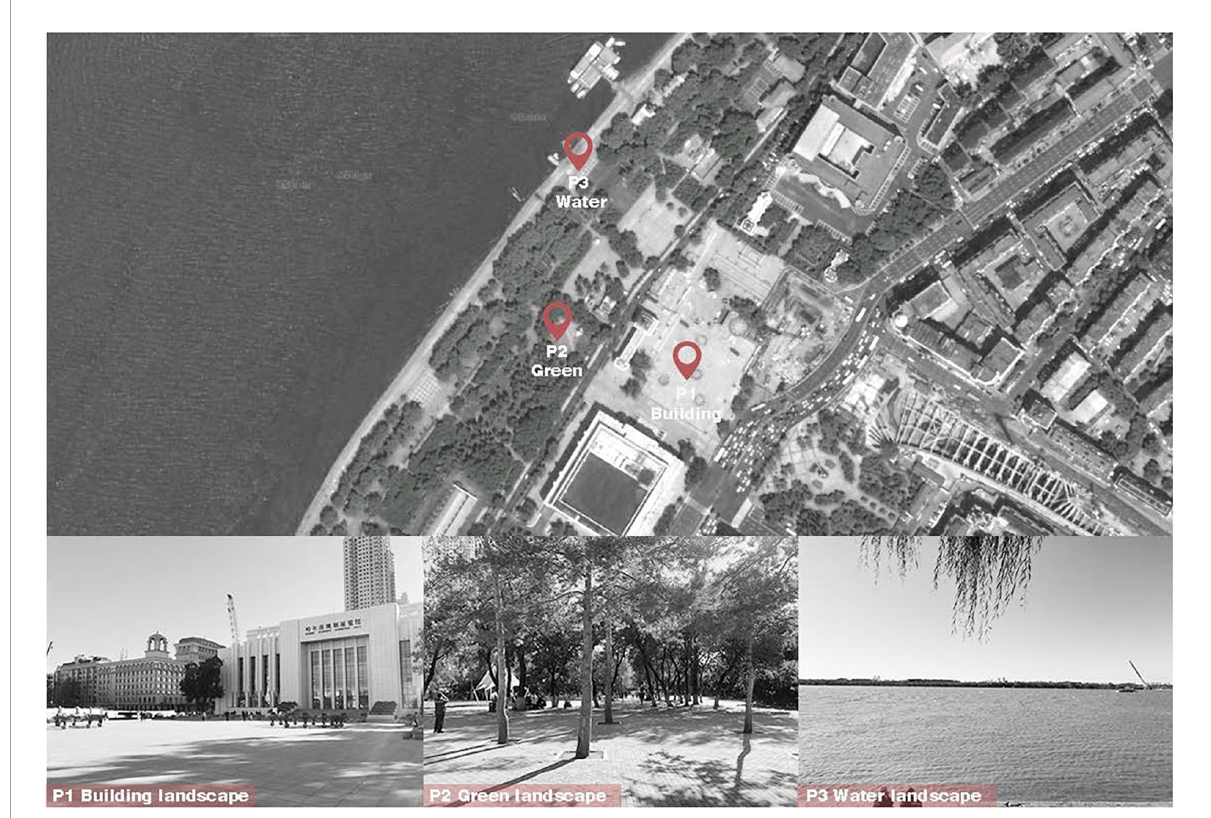
FIGURE1 Locations of questionnaire survey and the measurement sites. The figure of Locations adapted from Baidu Maps, available at